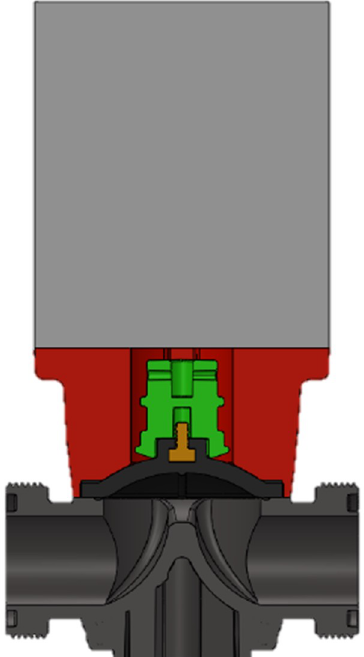
Figure 4. Automatic valve section, in red the part to be redesigned and assessed (support).